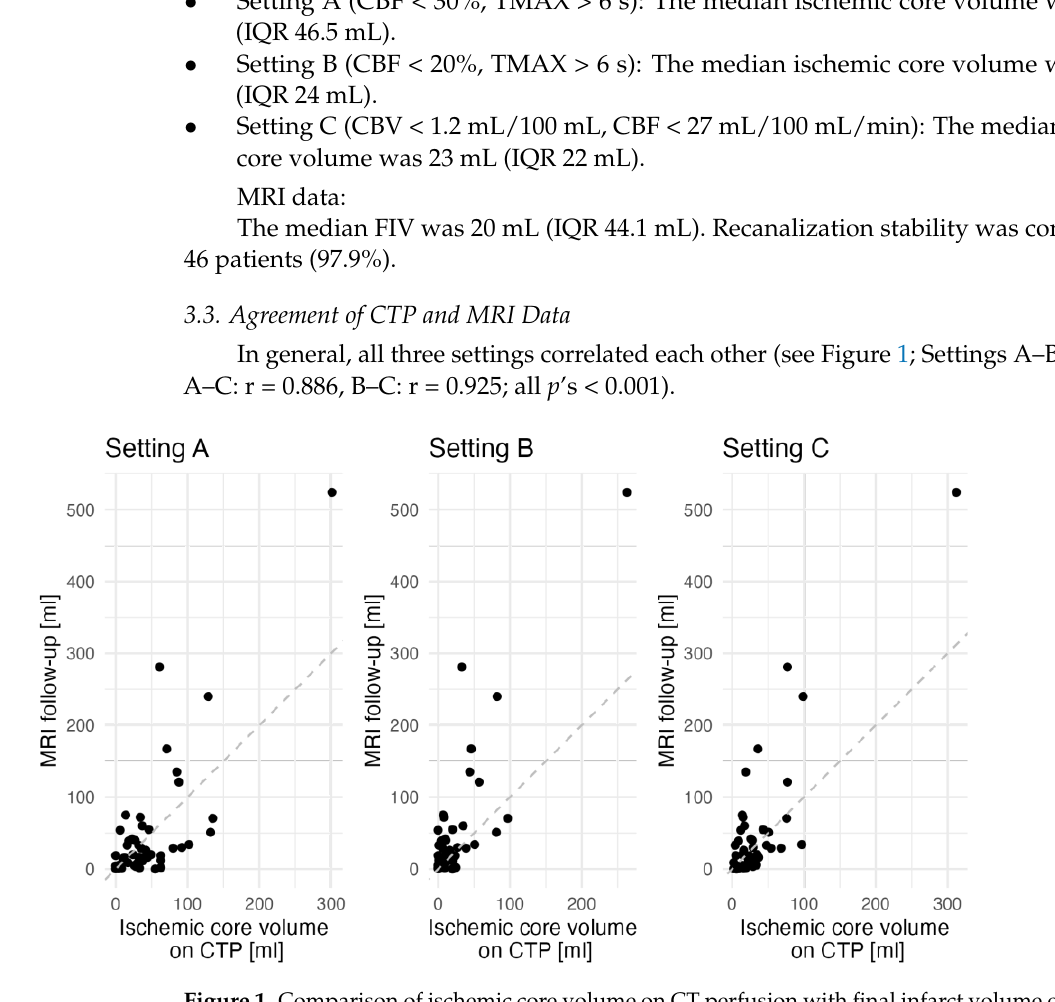
Figure 1. Comparison of ischemic core volume on CT perfusion with final infarct volume on magnetic resonance imaging follow-up for three different settings.